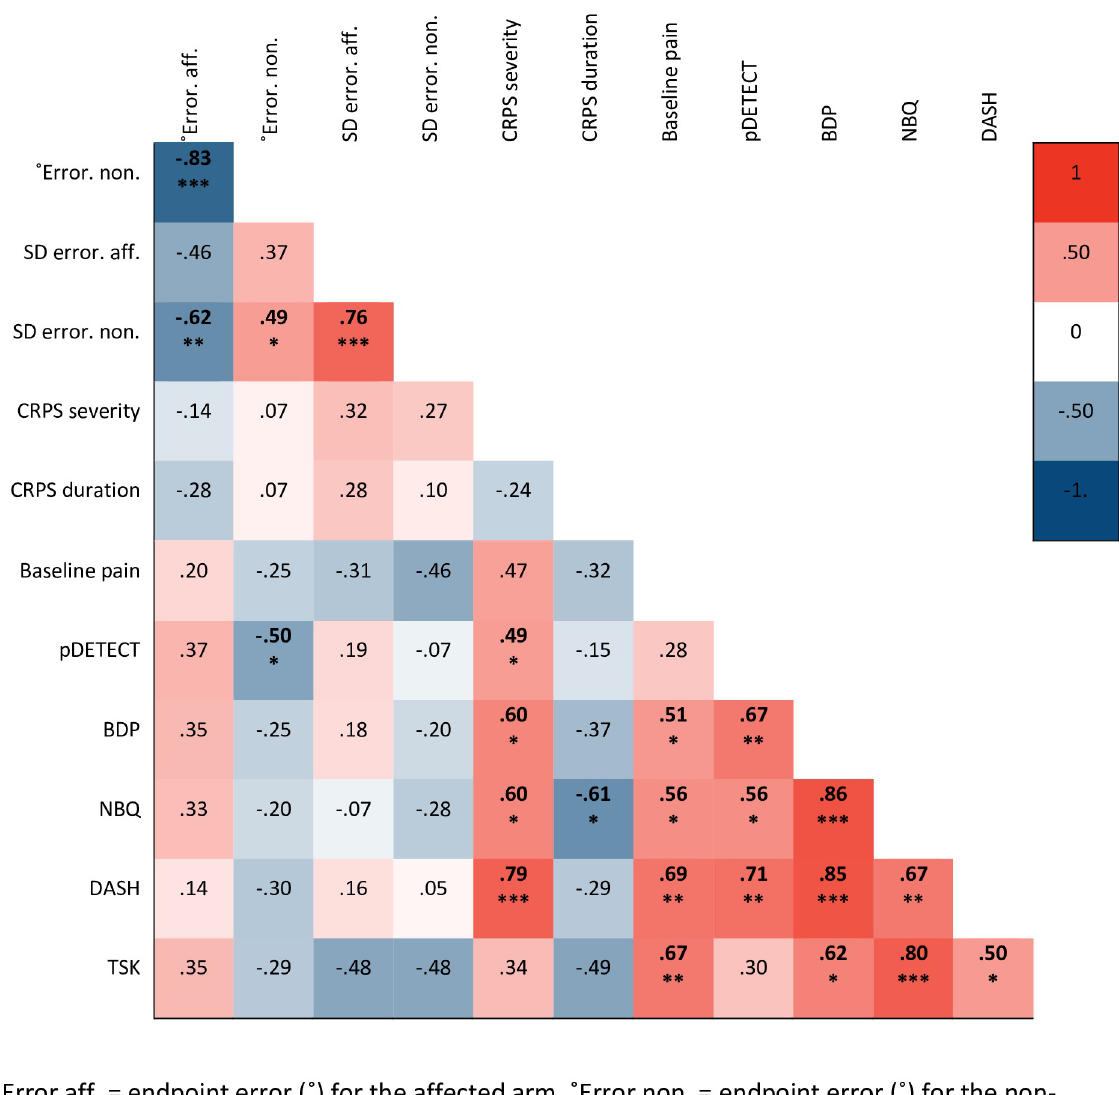
Fig 2. Correlation matrix for people with upper limb CRPS. Pearson correlation matrix for people with upper limb CRPS ( n = 17). CRPS severity was calculated based on the Budapest criteria [1, 2, 37], where a higher score (/16) indicates more signs and symptoms. Significant correlations (i.e. p < 0.05) are presented in